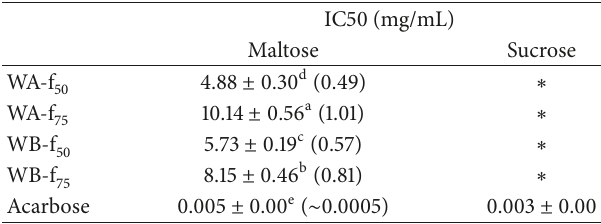
Figure 1: Effect of water extractable arabinoxylan on starch hydrol- ysis. Table 2: Effect of feruloylated arabinoxylan on intestinal 𝛼 - glucosidase when sucrose or maltose was used as